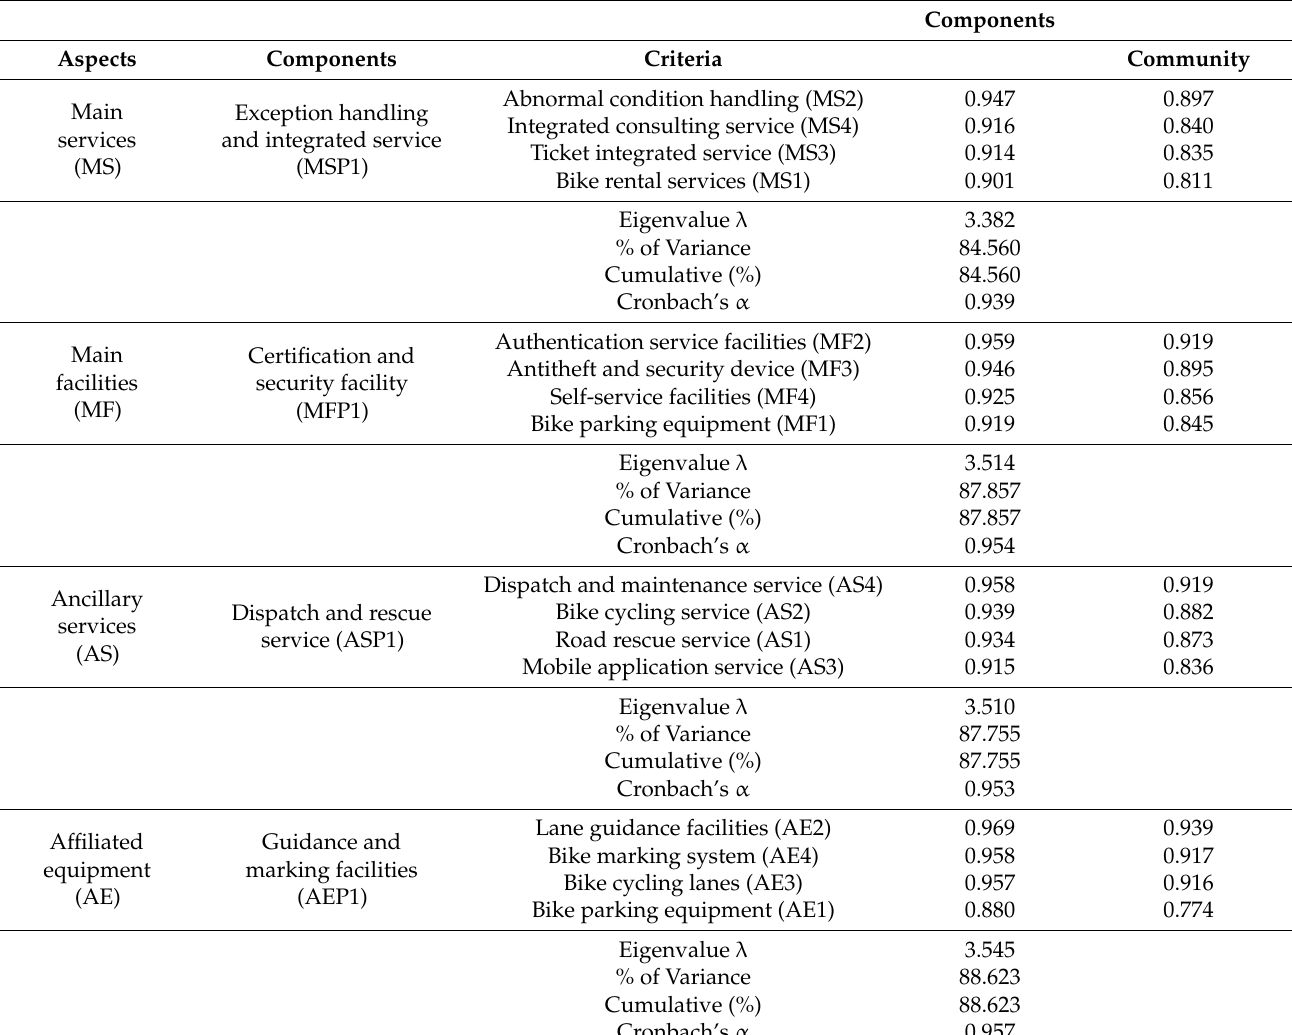
Table 15. The PCA analysis for the